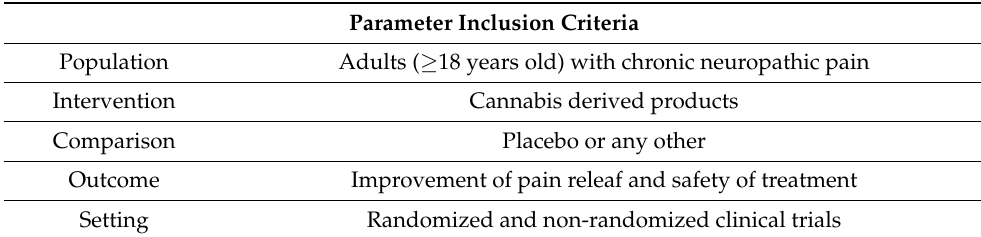
Table 1. PICOS (population, intervention, comparison, outcome, setting) criteria for inclusion of studies.